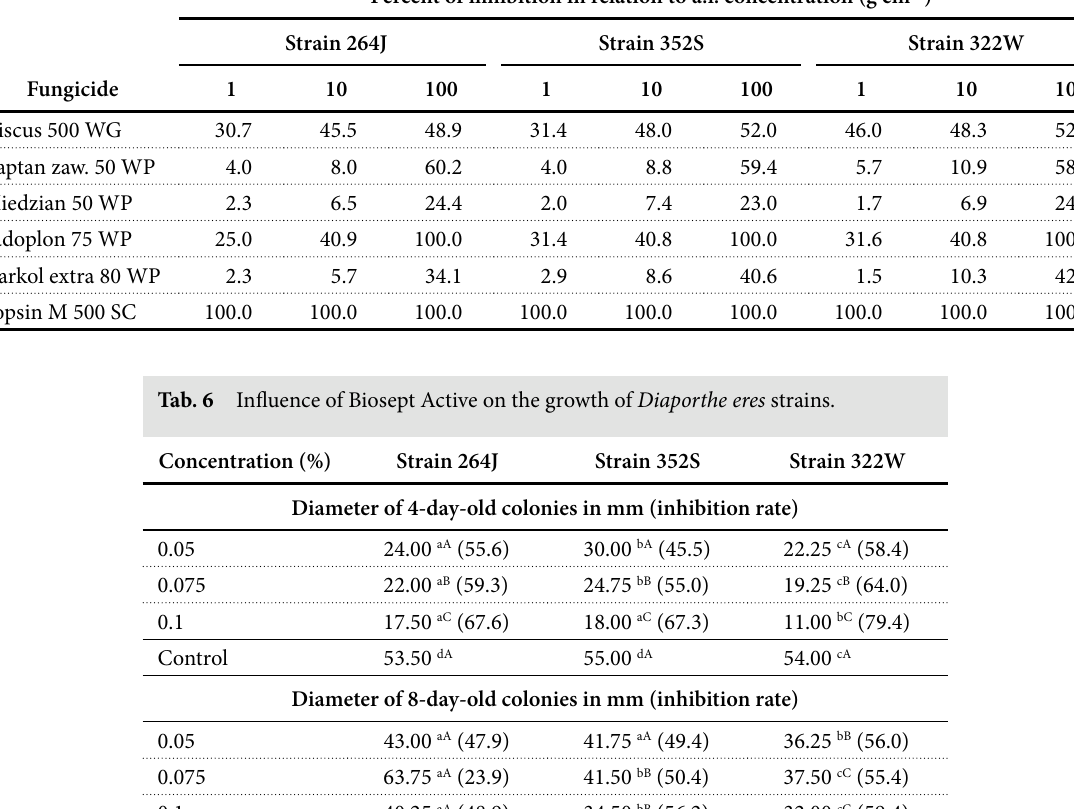
Tab. 5 Inhibition of colony growth of Diaporthe eres strains after 8 days of cultivation.